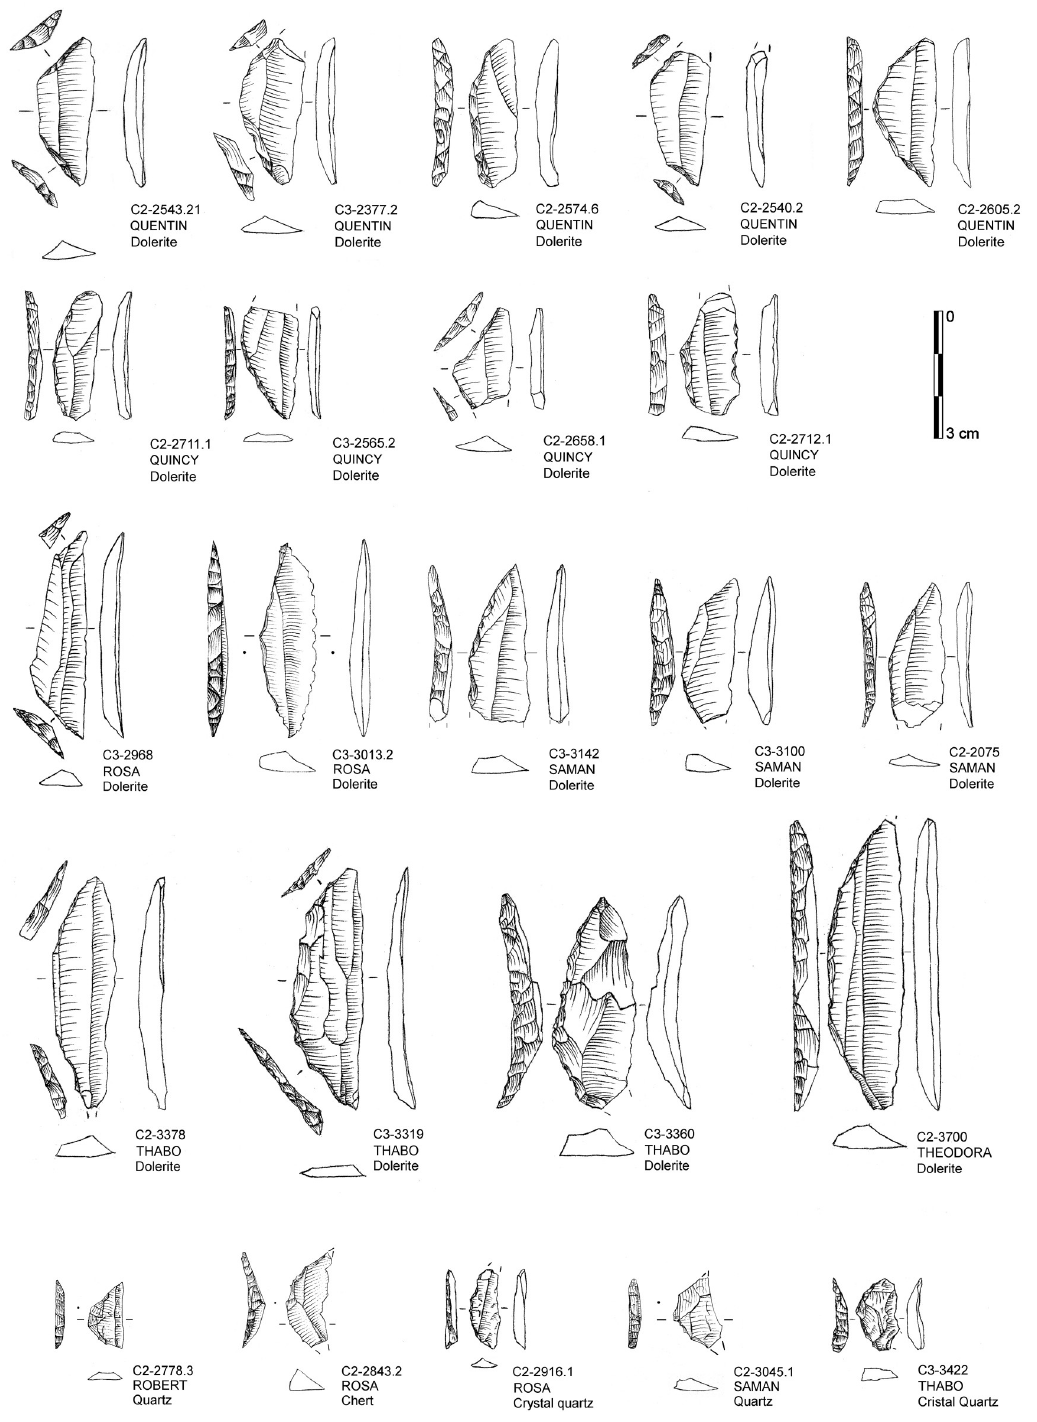
Fig 6. Drawings of various forms of backed pieces from Sibudu with indication of find number, raw material and layer.